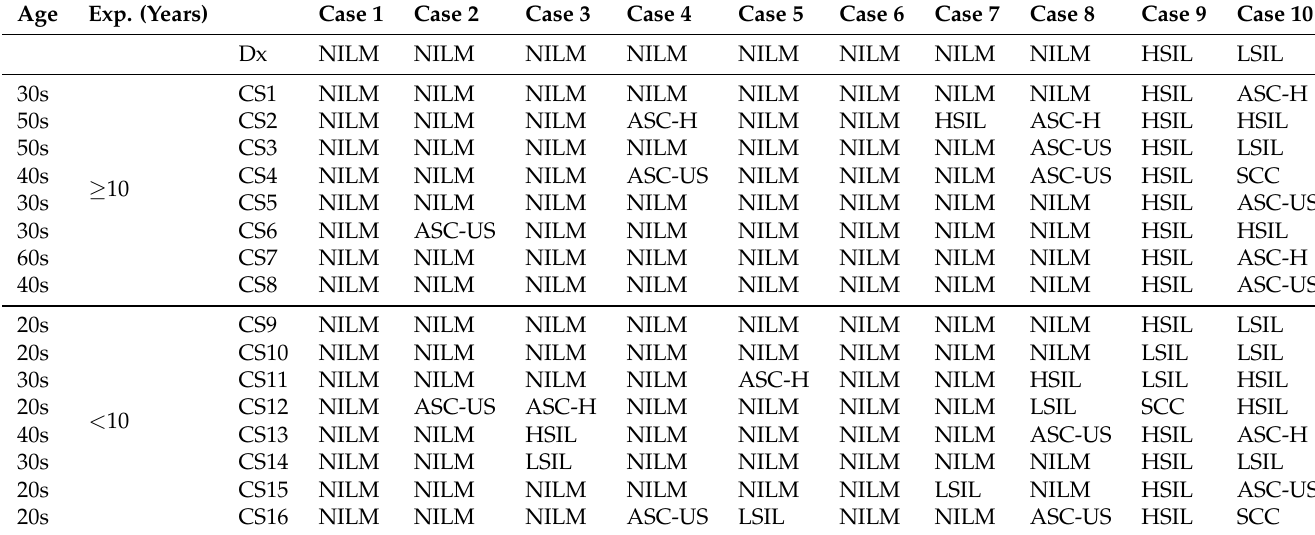
Table 4. Cytopathological evaluations for 10 LBC WSIs by diagnostic report (Dx) and 16 cytoscreeners (CS) with their age and years of experience.